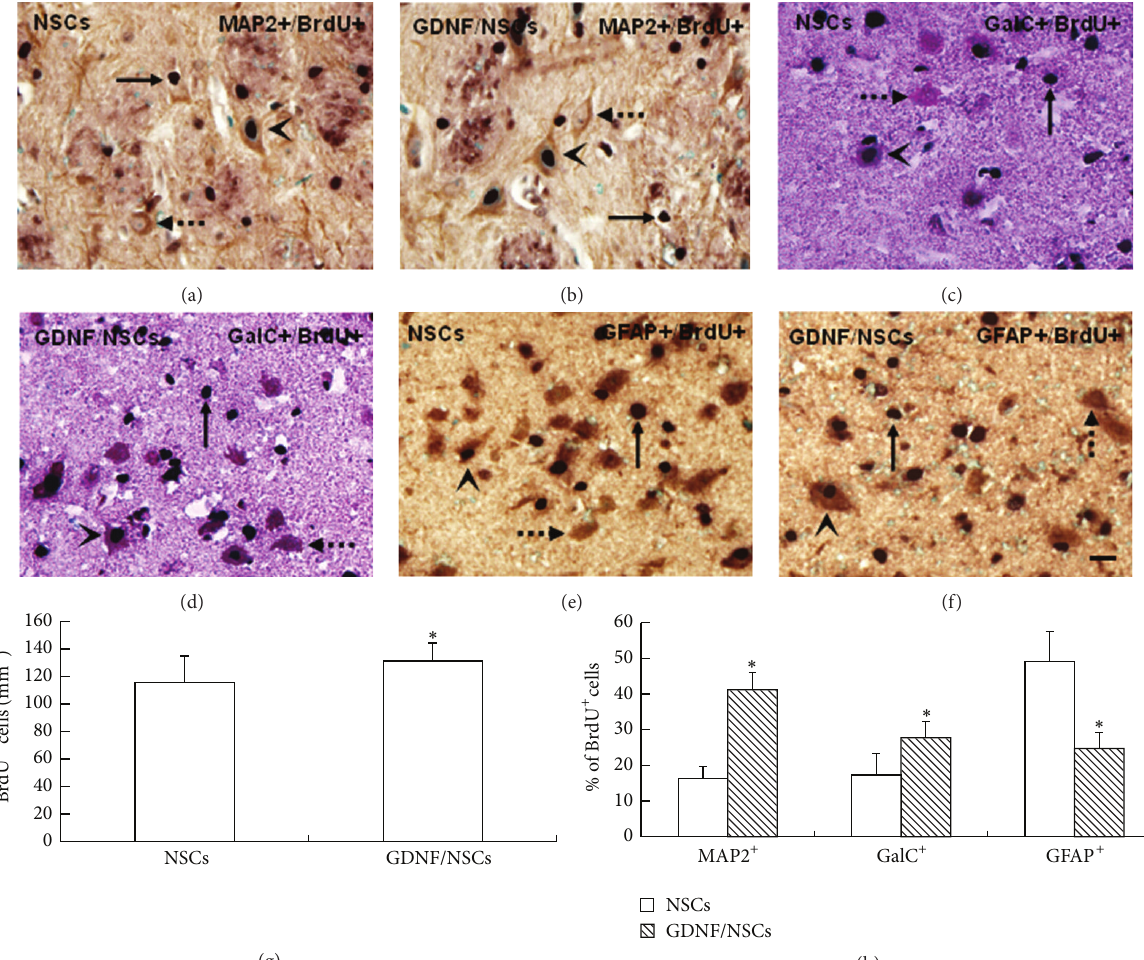
Figure 4: Double-immunohistochemical staining showed differentiation of transplanted NSCs or GDNF/NSCs in the corpus striatum. (a, b) BrdU + cells (solid arrow), MAP2 + cells (dotted arrow), and MAP2 + /BrdU + cells (arrowhead) in NSCs group and GDNF/NSCs group, respectively. (c, d) BrdU + positive cells (solid arrow), GalC + cells (dotted arrow), and GalC + /BrdU + cells (arrowhead) in NSCs group and GDNF/NSCs group, respectively. (e, f) BrdU + cells (solid arrow), GFAP + cells (dotted arrow), and GFAP + /BrdU + cells (arrowhead) in NSCs group and GDNF/NSCs group, respectively. (g) Quantitative analysis of BrdU + cells in NSCs and GDNF/NSCs groups (mean ± SD, 𝑛 = 5 ). ∗ Compared with NSCs group, 𝑃 < 0.05 . (h) Quantitative analysis of the ratio of transplanted NSCs and GDNF/NSCs differentiated into each type of neural cells (mean ± SD, 𝑛 = 5 ). ∗ Compared with NSCs group, 𝑃 < 0.05 . Bar = 25 𝜇 m.